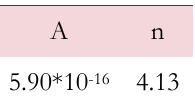
Figure 7: log–log plot of sscr-stress points.